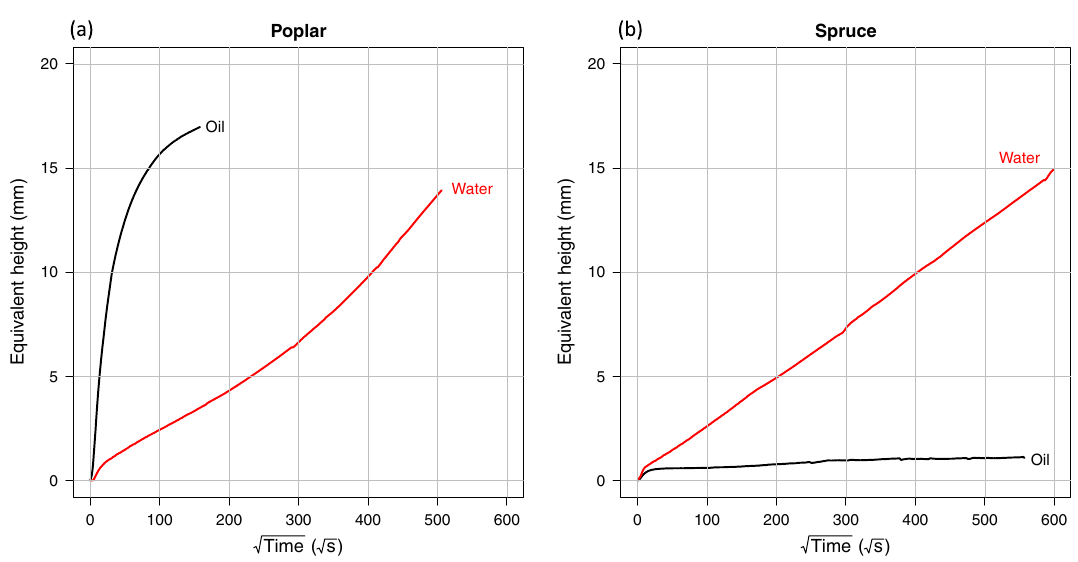
Figure 8. Macroscopic imbibition kinetics obtained for the two species and the two